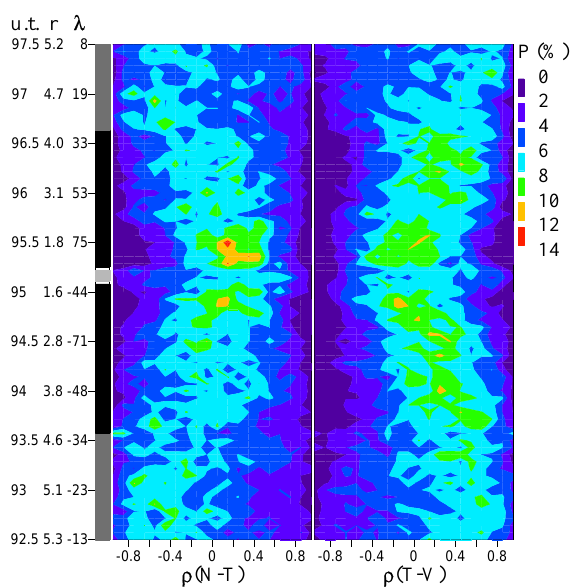
Fig. 4. Solar rotation histograms of ρ(N − T ) and ρ(T − V ) in the same format of Fig. 2, apart from a change in the colour scale for the occurrence frequency P